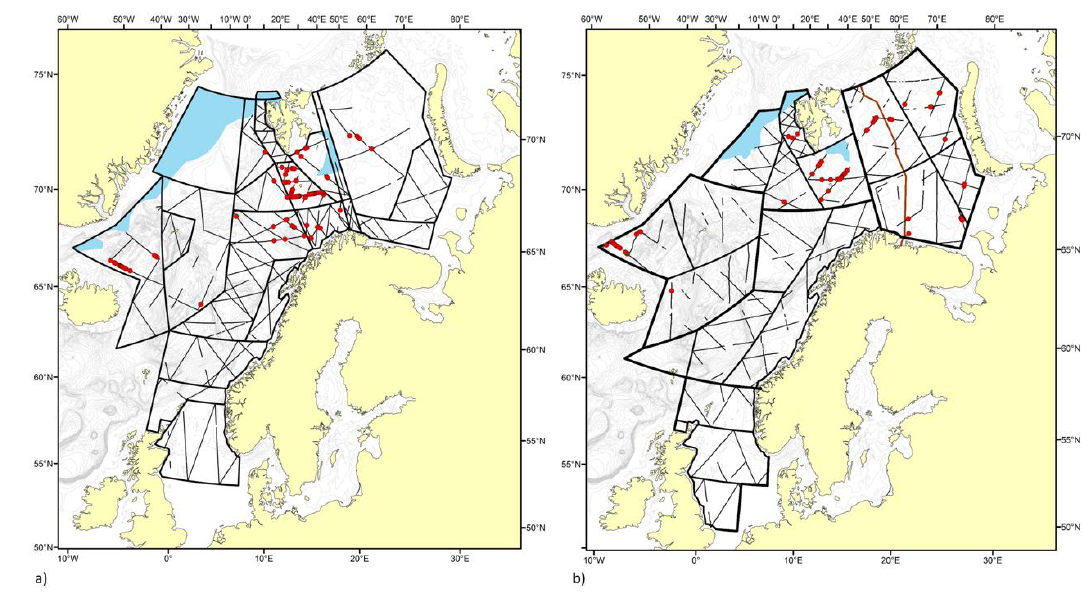
Figure 6. Distributions of sightings recorded as humpback whales during (a) the 2002 – 2007 surveys and (b) the 2008 – 2013 surveys. The blue areas represent ice coverage.